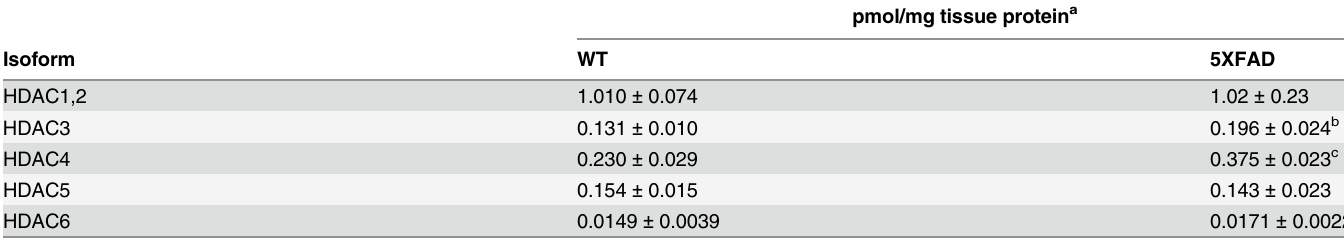
Table 3. HDAC concentrations in whole hemisphere of mouse